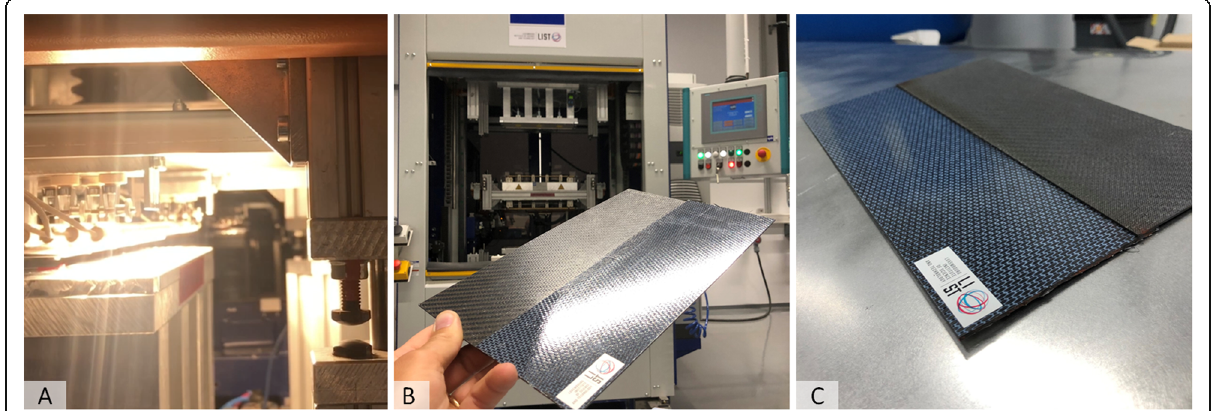
Fig. 3 a View of the lower tool during the heat phase; b IR welding equipment; c TPC/TSC welded